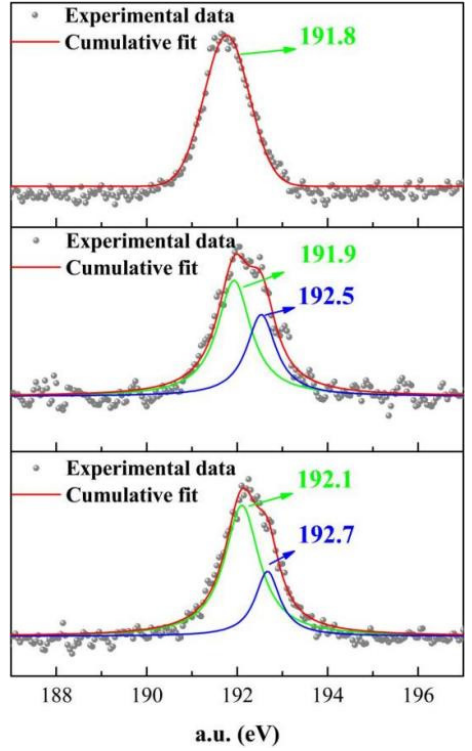
Figure 11. XPS under pH = 7, pH = 11, and pH = 14.